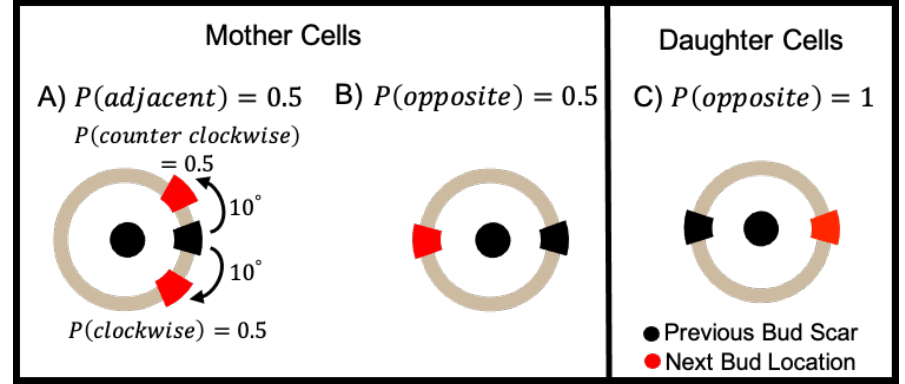
Figure 13. Selecting a Bud Site. The choice of the next bud location for a cell depends on whether it is a mother cell (left) or a new daughter cell (right). (Left) For mother cells, the next bud location will be chosen either adjacent to the previous bud scar with probability 0.5 ( A ) or opposite to the previous bud scar with probability 0.5 ( B ). In the case when the location of the new bud site overlaps with a previous bud site ( A ), we adjust the location of the new bud site by increments of 10 ◦ in either the clockwise (probability 0.5) or counterclockwise (probability 0.5) direction until we arrive at a location with no previous bud scar. (Right) For new daughter cells the next bud location (red) is chosen opposite to the previous birth scar (black) with probability 1 ( C ). New daughter cells that have successfully completed a full cell cycle are considered mother cells for the remainder of the simulation. (See Section